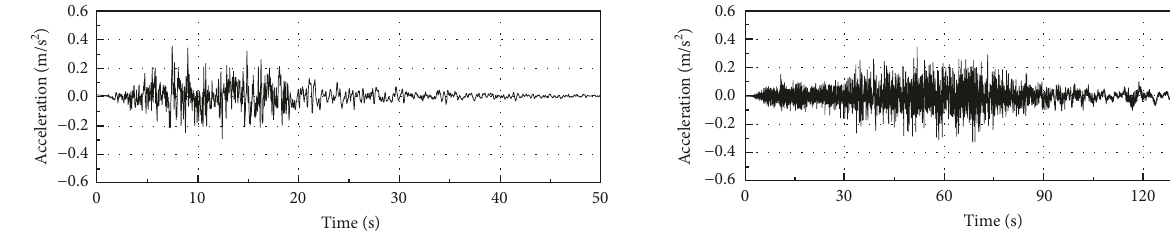
Figure 8: Earthquake acceleration time-history curve of intensity 7 frequently of Alaska (transverse input).